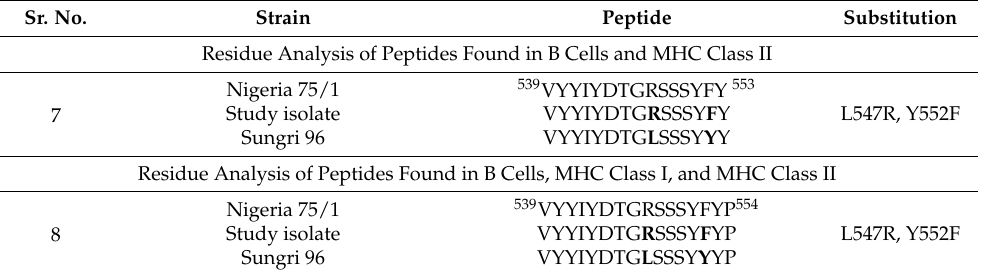
Table 3. Cont. Sr. No. Strain Peptide Substitution Residue Analysis of Peptides Found in B Cells and MHC Class II